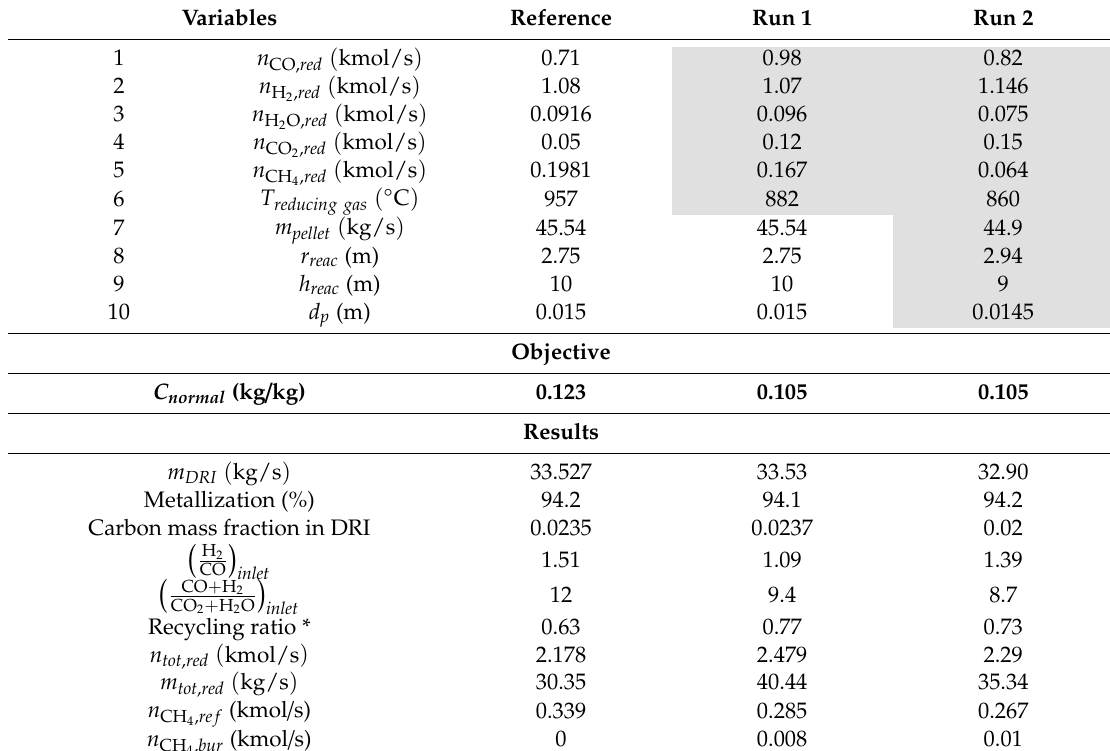
Table 3. Values for key design parameters and results. The variables with a grey background are optimization